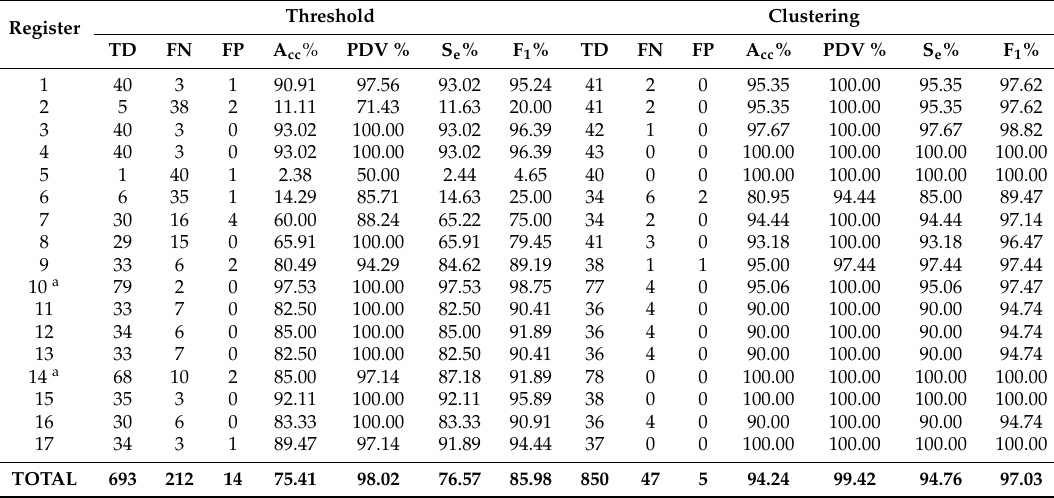
Table 1. Results for QRS-complex extraction from ECG